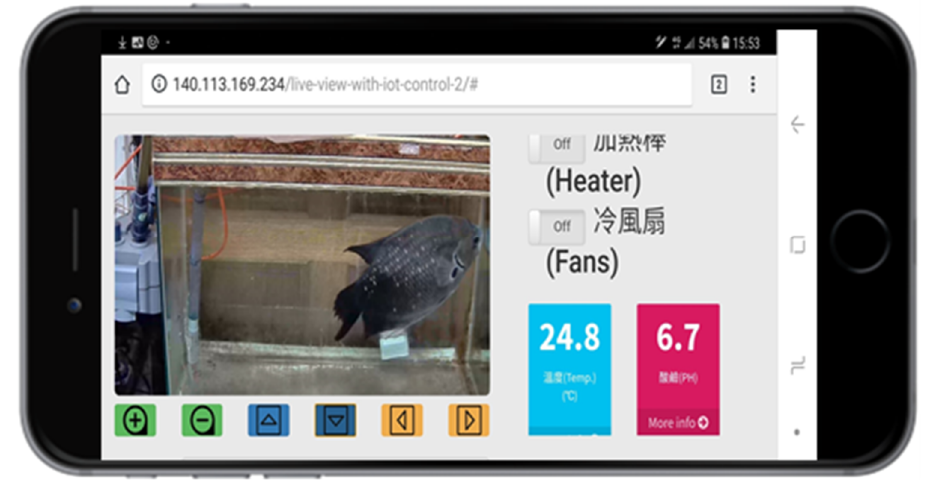
Figure 10. The video, dashboard and controls for the aquarium applications.